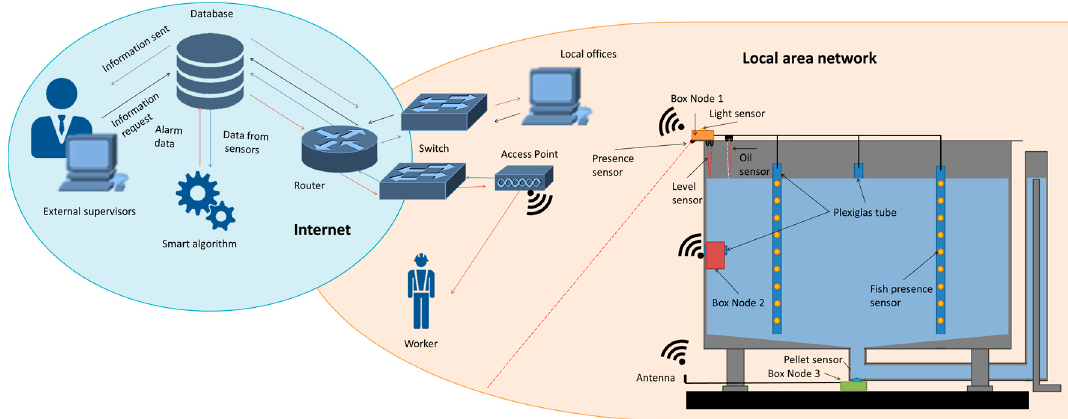
Figure 2. Architecture of the proposed system.